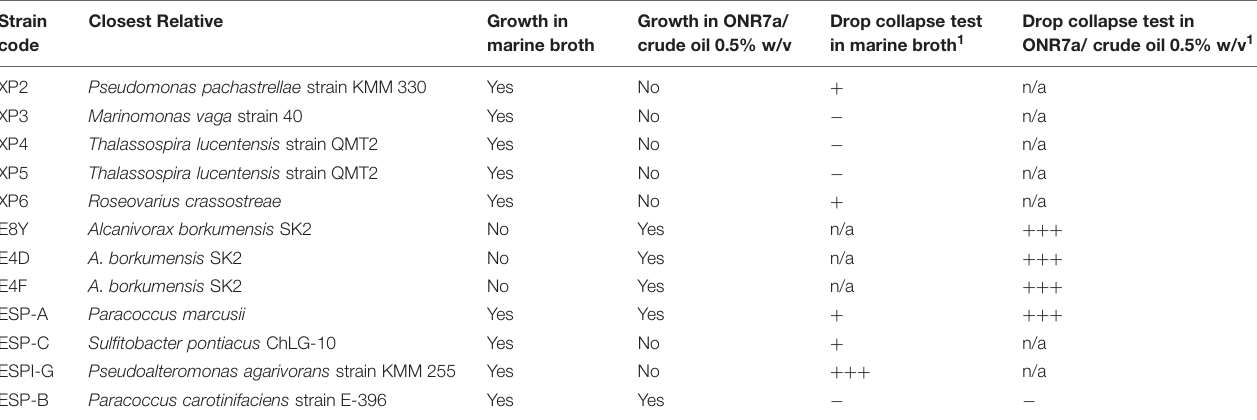
TABLE 3 | Code, phylogenetic identity, growth ability and drop collapse test results of the isolated pure strains. Strain code